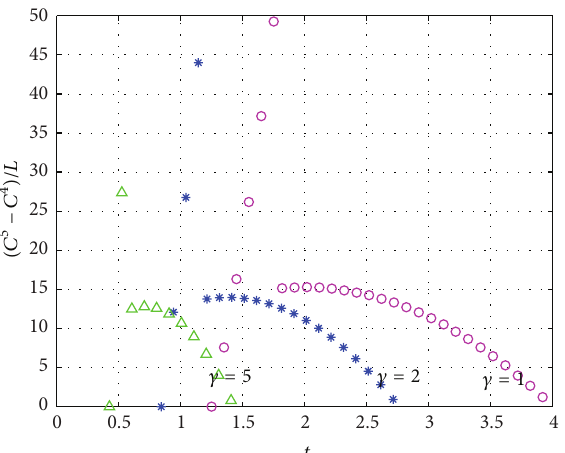
Figure 4: The severity that the paradox occurs when 𝛾 is different.